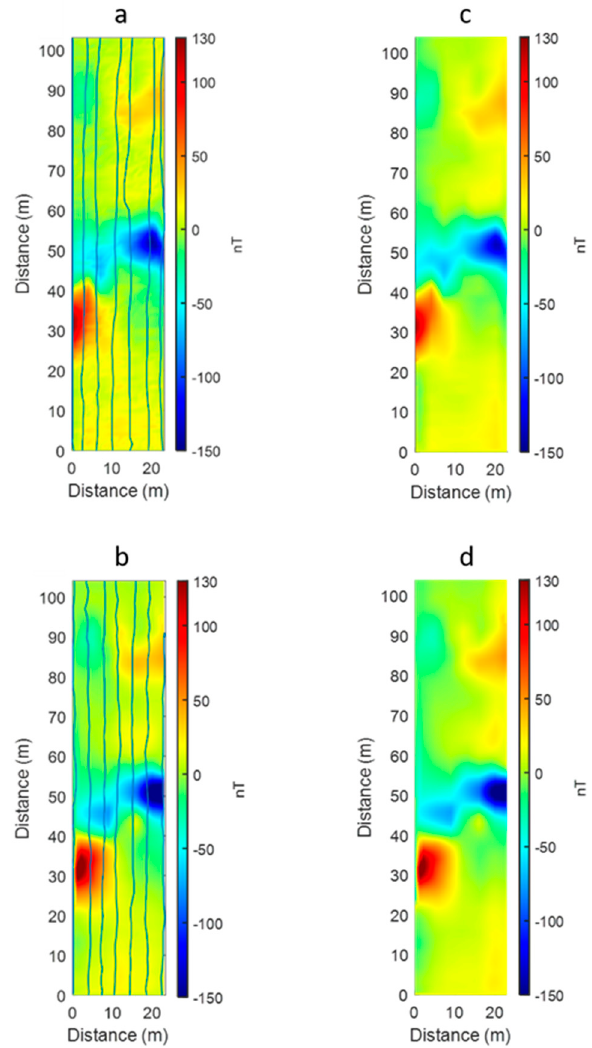
Figure 8. Magnetic anomaly maps. ( a ) F0.5 survey, raw data; ( b ) F0.5 survey, filtered data; ( c ) F3.0 survey, raw data; ( d ) F3.0 survey, filtered data. The blue lines in ( a , c ) represent the true flight paths during the two surveys.